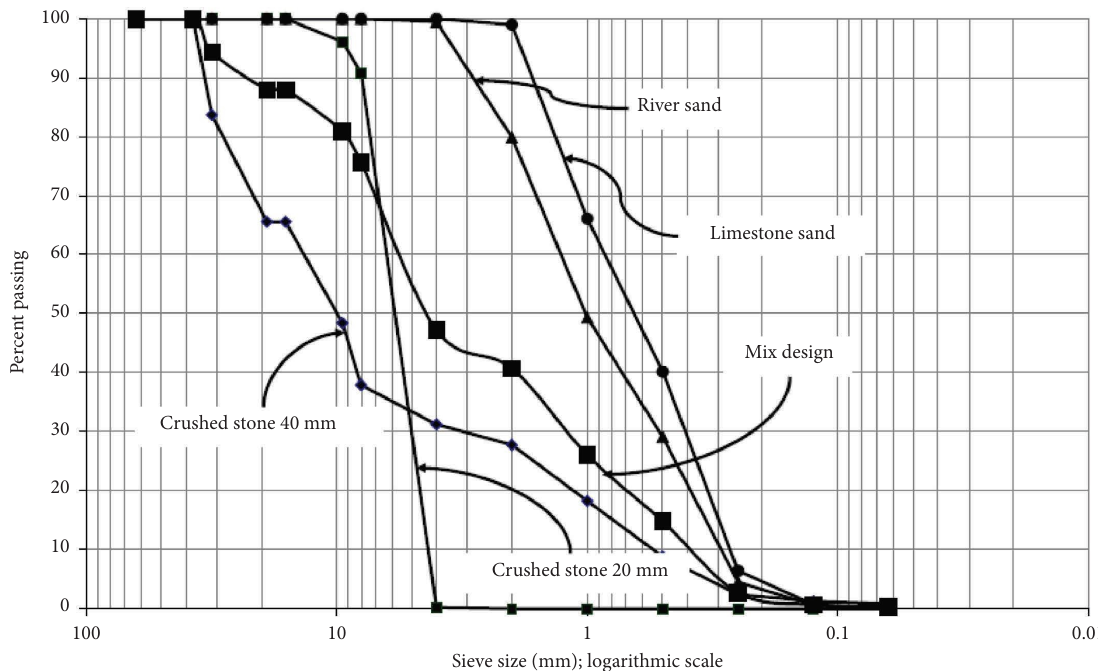
Figure 4: Granulometric curve.